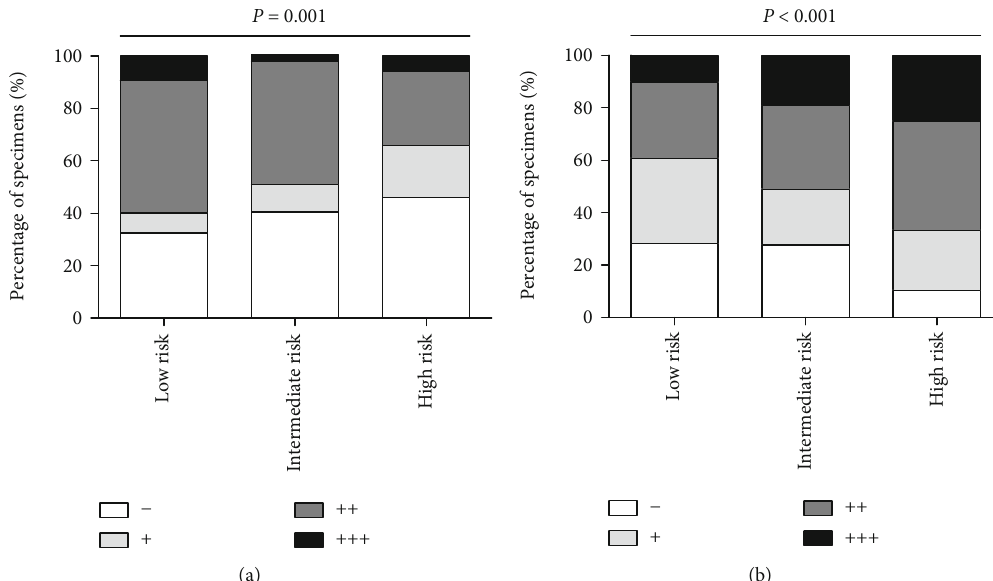
Figure 4: Statistical analysis of IHC scores for TIM-3 + (a) and Gal-9 + (b) TIL distribution in di ff erent risk of GIST patients, P = 0 : 001 and P < 0 : 001 , respectively. Table 3: Distribution correlation of various TIL subsets in GIST. CD8 + cell